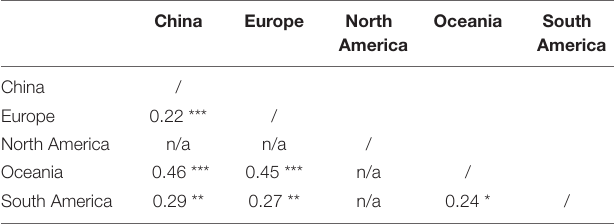
TABLE 2 | Pairwise F ST between geographic populations of